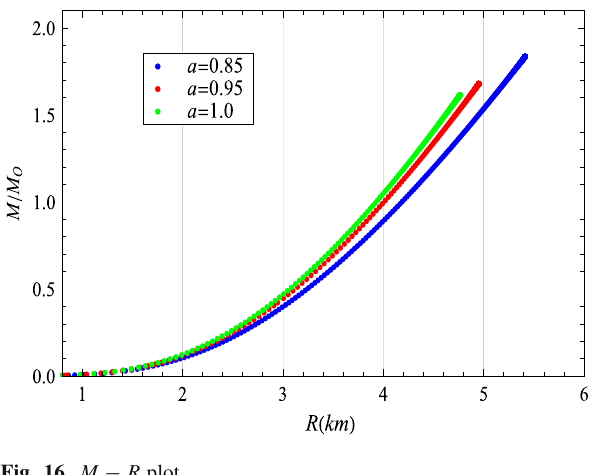
Fig. 15 Mass radius ratio (compactness factor μ ) against radial dis- tance r